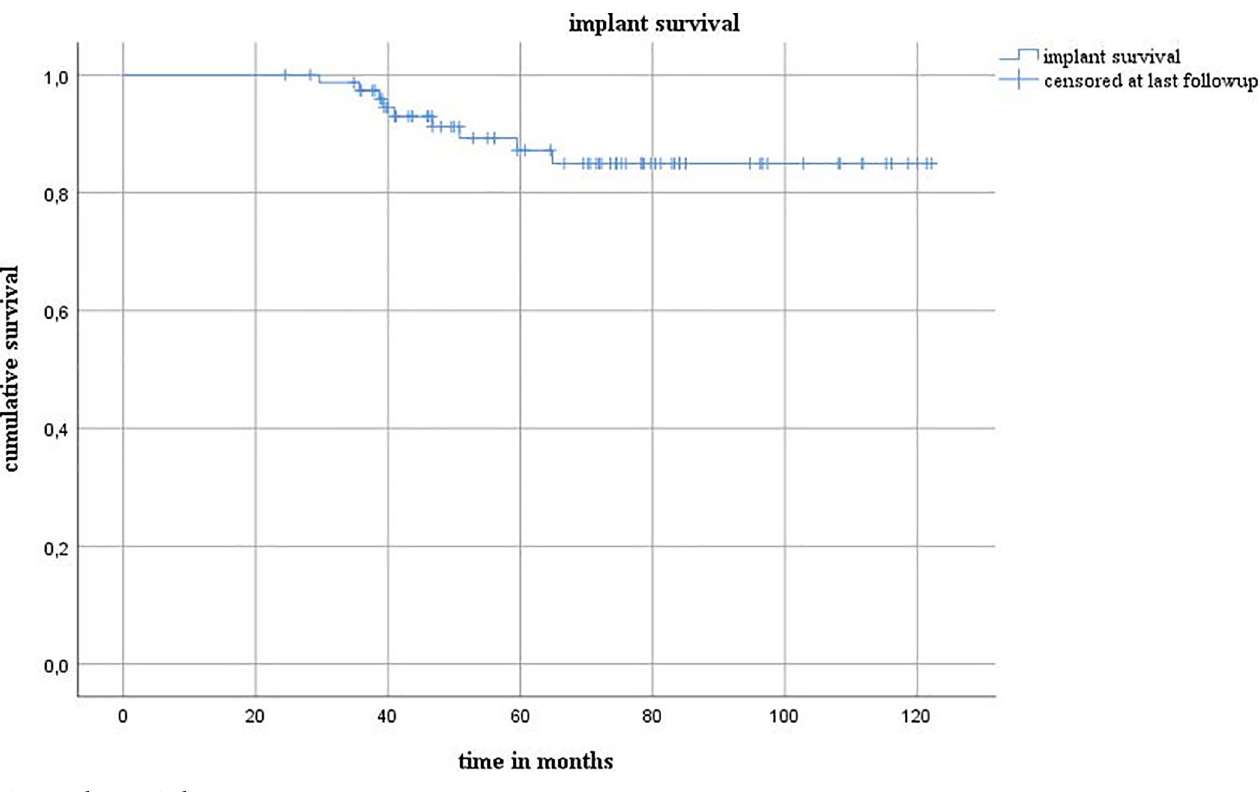
Fig 1. Implant survival.